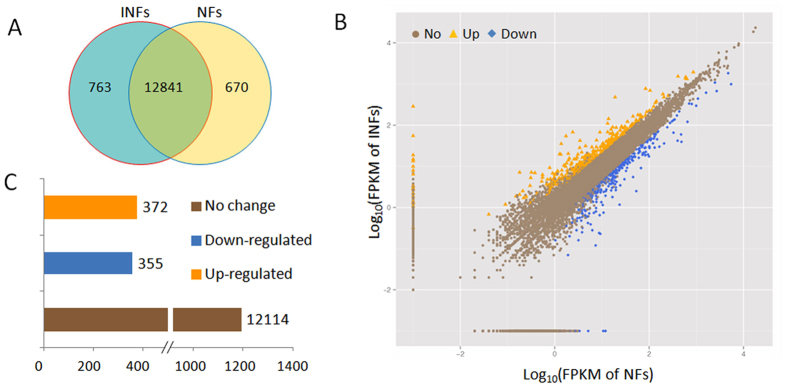
RNA-Seq gene expression results in NFs and INFs.(A) Venn diagram showing the number of co-expressed genes and unique genes between NFs and INFs. (B) Scatter plot of co-expressed genes between NFs and INFs. Blue denotes downregulated genes, orange denotes upregulated genes, and brown denotes non-regulated genes in INFs compared with NFs under the criteria of a FDR < 0.001 and absolute log2 (Y/X) > 1. (C) Histogram showing the number of differentially expressed genes and non-regulated genes between INFs compared with NFs.